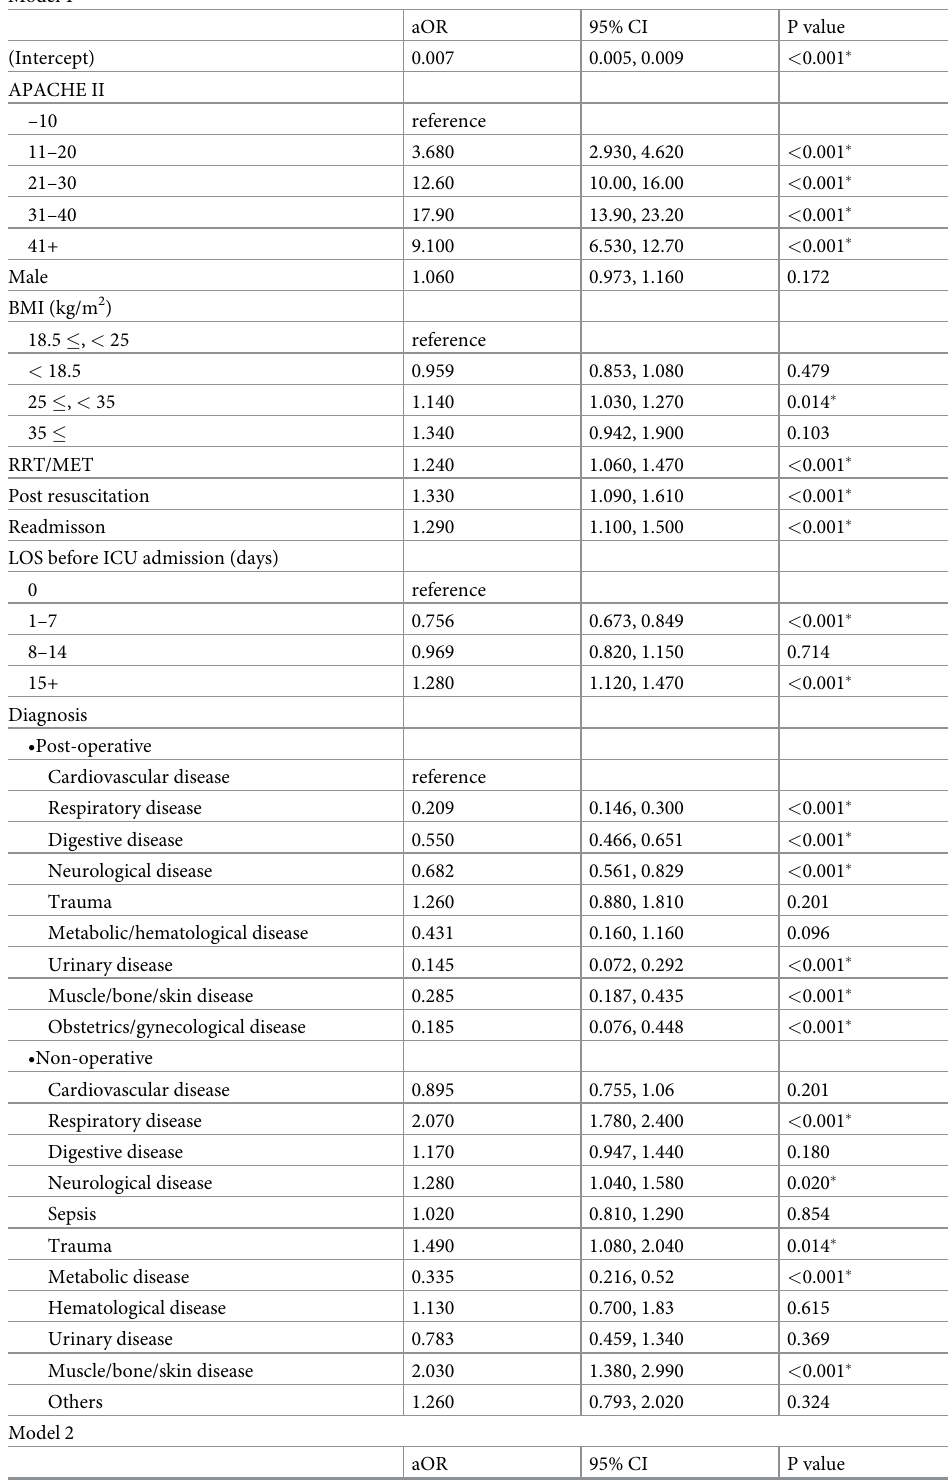
Table 5. Predictive model for prolonged ICU stay using APCHE II, APCHE III and SAPS II